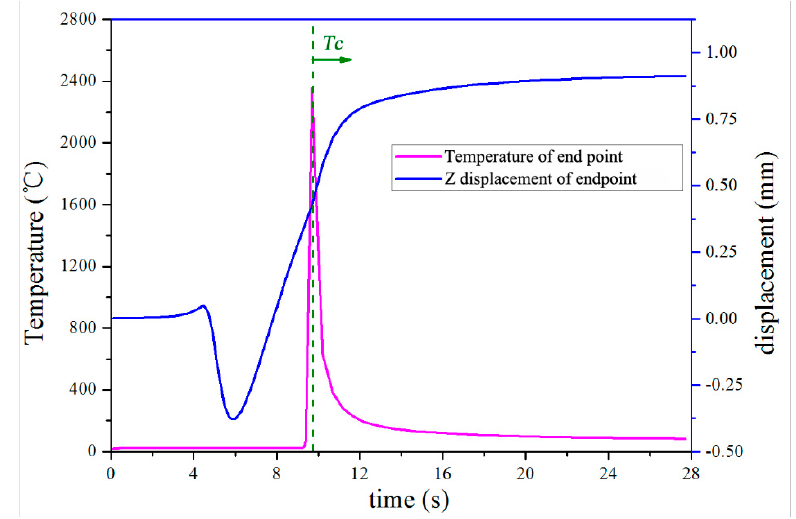
Figure 7. The changes in temperature and distortion over time.